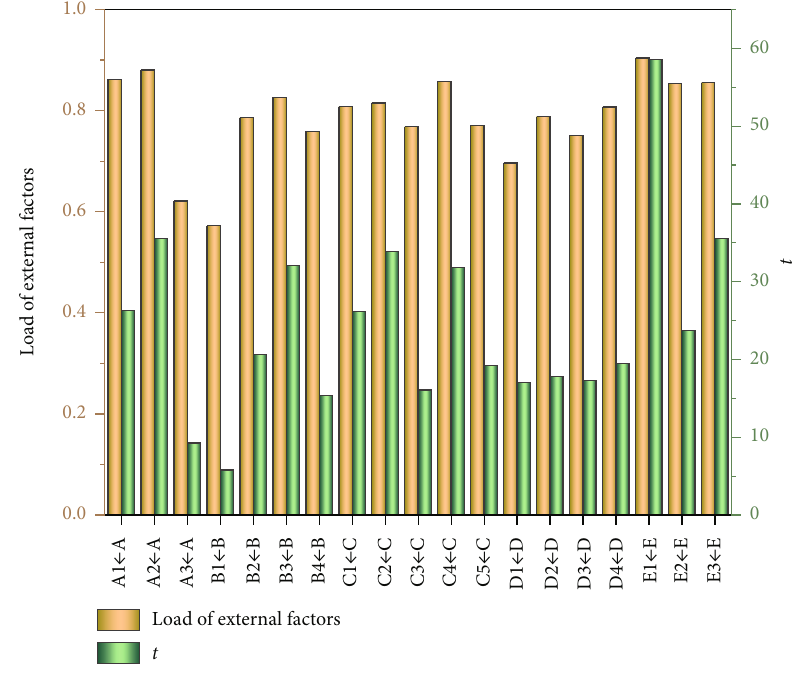
Figure 7: External model loads between explicit variables and latent variables of the model.